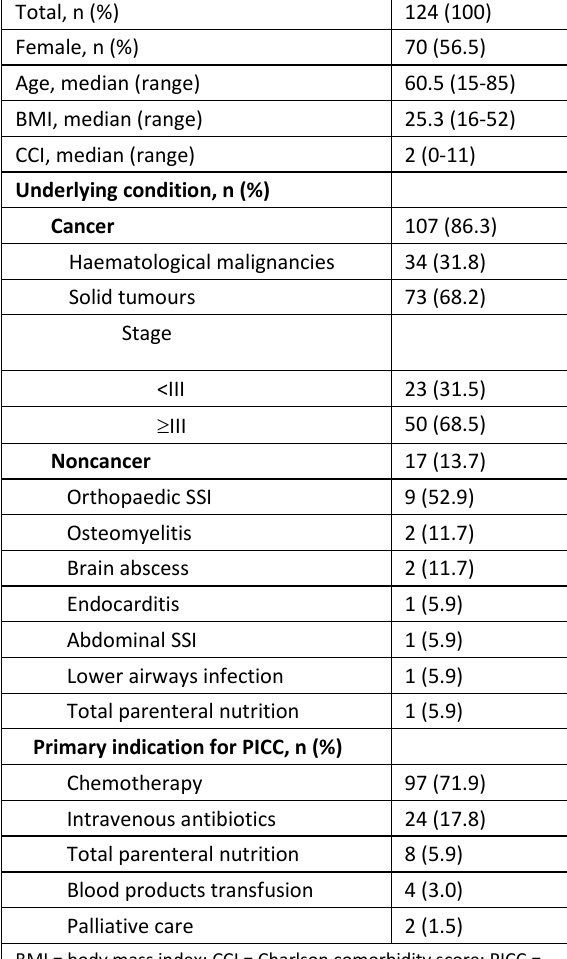
Table 1: Characteristics of the 124 patients within the PICC pilot programme.